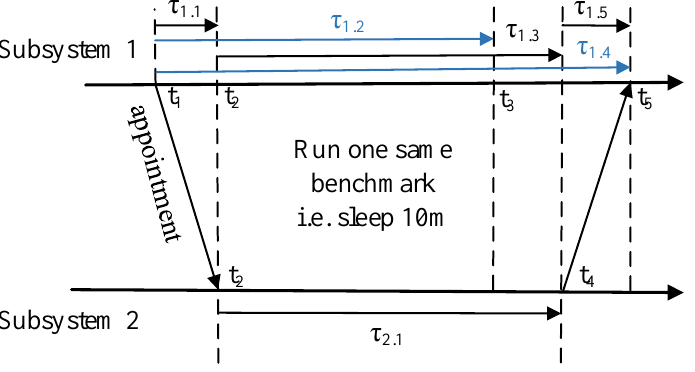
Figure 6. Appointment and execution method for relative frequency scale calculation.